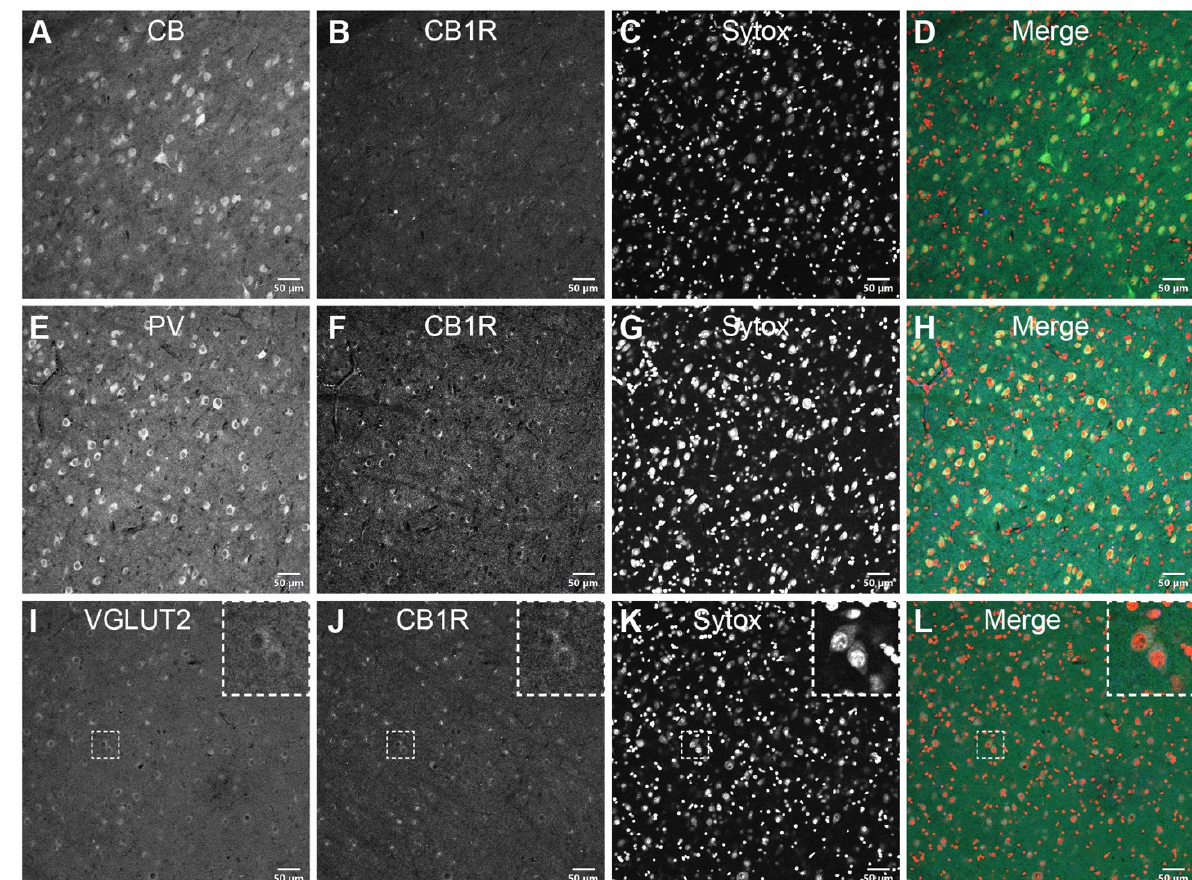
Figure 3. CB1R distribution in the inferior pulvinar. CB-positive ( A – D ) and PV-positive ( E – H ) neurons are shown in adjacent coronal sections of the vervet monkey pulvinar. In opposition to this diffuse and intense perinuclear staining pattern, CB1R-immunoreactivity closely matches the VGLUT2 annular-shaped terminal-like distribution ( I – L , insets). The dashed squares in panels I – L indicate representative cells displayed at a higher magnification in the respective insets (3 × digital zoom). Nuclear counterstaining with Sytox orange is shown in the third column of each panel. CB: calbindin-D28k; CB1R: cannabinoid receptor type 1; PV: parvalbumin ; VGLUT2: vesicular glutamate transporter 2. Scale bar = 50 µm.